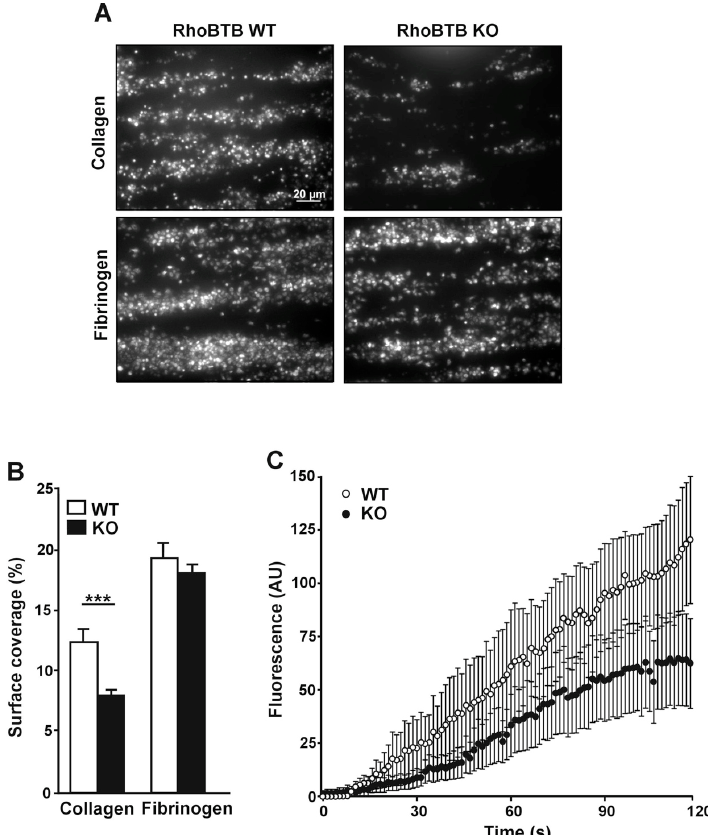
Figure 5. Behavior of RhoBTB3 KO and WT platelets on collagen or fibrinogen coated surfaces under flow. ( A ) Whole blood was stained with 1 µ M DiOC6 for 10 min at 37 ◦ C and perfused through 50 µ g/mL collagen or 1 mg/mL fibrinogen coated capillary tubes at a shear rate of 1000 s − 1 for 2 min. Representative images after 2 min are shown. ( B ) Quantification of surface coverage. Data are average ± SEM of images like those of panel A from 3 (fibrinogen) or 4 (collagen) independent experiments after 10 min of perfusion. *** p < 0.001, Mann-Whitney U-test. ( C ) Adhesion of platelets to collagen under flow as a function of time. Fluorescence intensity was calculated from images like those of panel A by thresholding using ImageJ. Data are average ± SEM of 4 independent experiments.